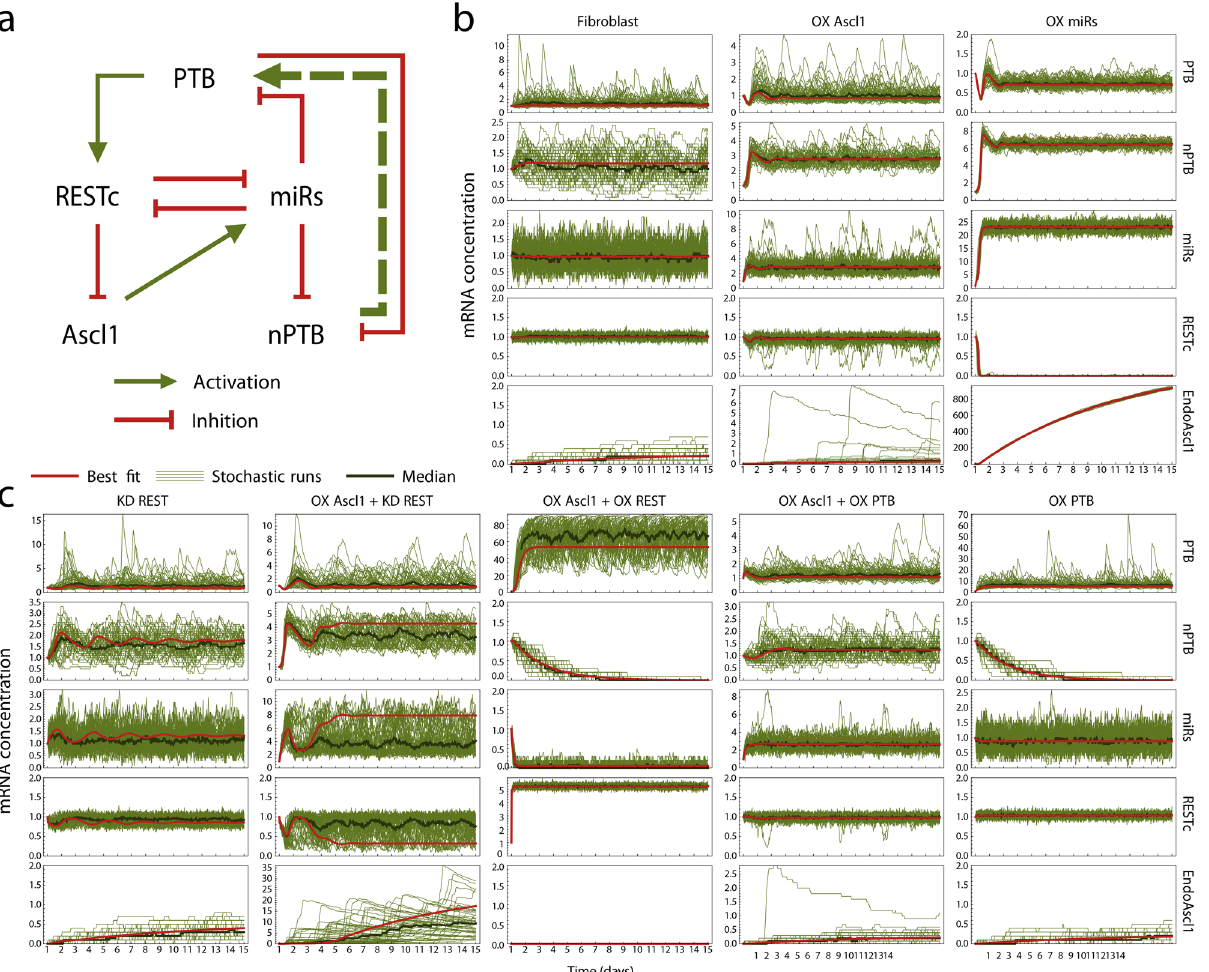
Figure 4. The nPTB → PTB model correctly predicts conversion outcome of most overexpression and knockdown experiments. ( a ) Network topology of the nPTB → PTB model. ( b , c ) The deterministic (red) and stochastic (green) simulation outcomes are shown for OX/KD scenarios in the nPTB → PTB model. Similar simulations for all models and experiments are summarized in Table 2 and are shown in Supplementary Fig.1. The plots were made with Mathematica 11.3.0 (Linux version). https ://www.wolfr am.com/mathe matic